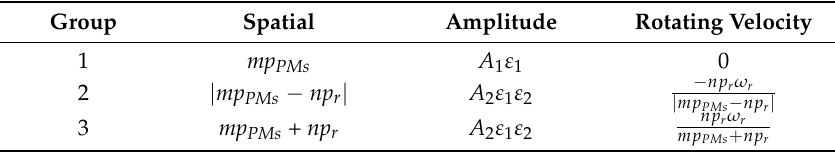
Table 1. Excited harmonic components by the PMs on outer